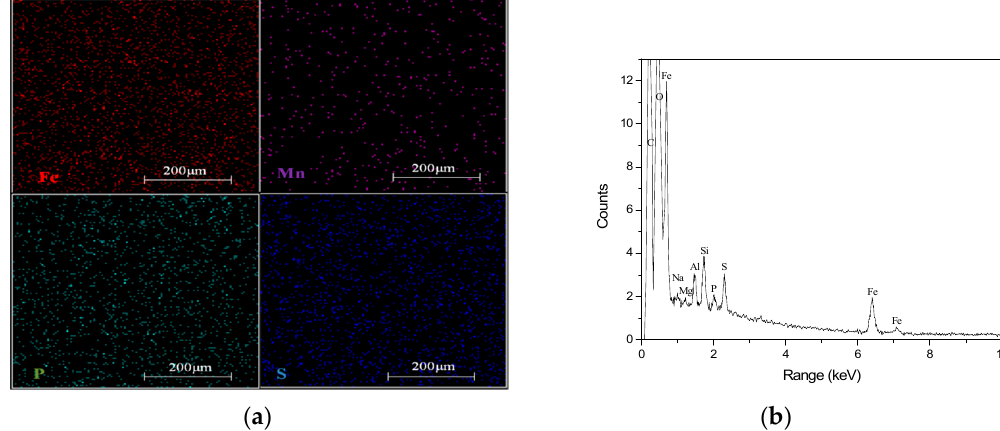
Figure 3. Energy Dispersive X-ray Spectrometry (EDS) on the root surface of G. spiculosa : distribution of Fe, Mn, P, and S ( a ), and a quantitative determination of elements composition ( b ).